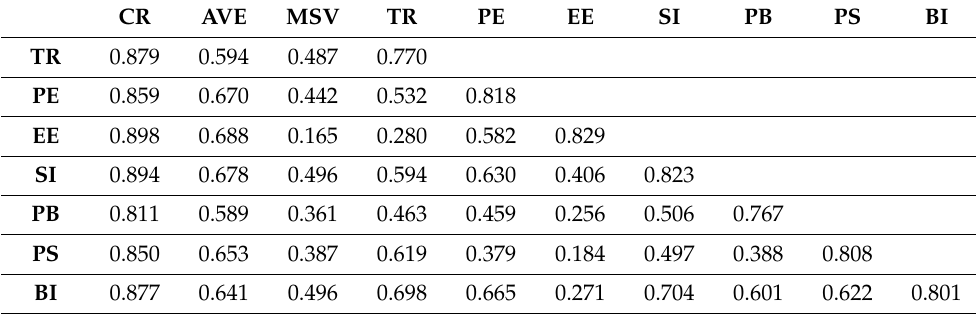
Table 4. Descriptive statistics and correlation among constructs.